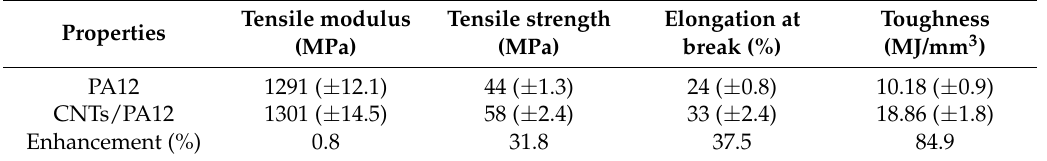
Table 5. Comparison of the mechanical properties of laser sintered PA12 and CNTs/PA12 parts. Properties